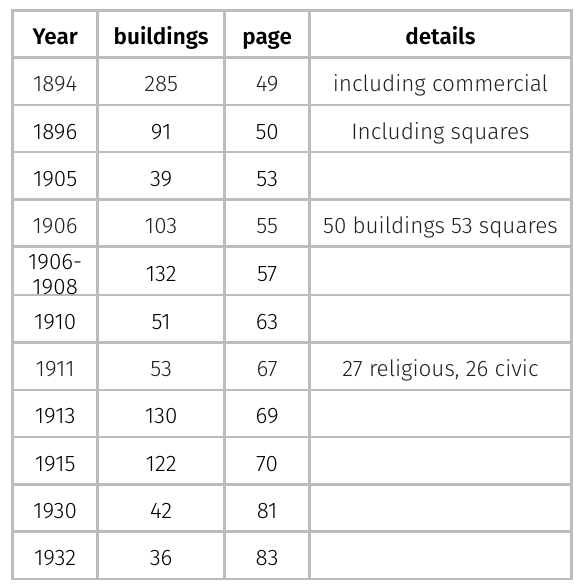
Table V. Number of main buildings per year in Bogotá based on the maps 1894-1933 according to (Cuéllar Sánchez & Mejía Pavony